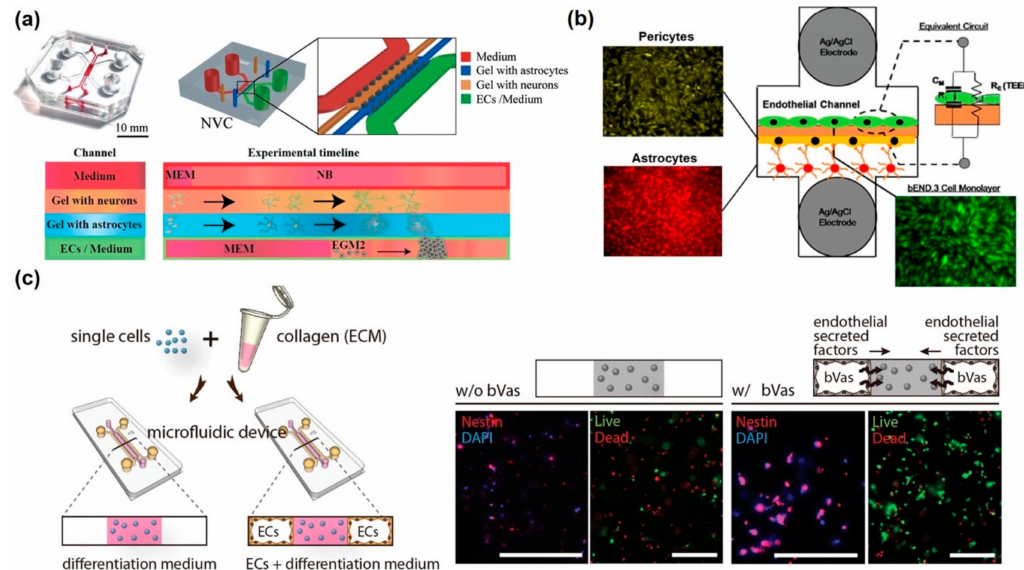
Figure 4. In vitro BBB-integrated neurovascular unit models. ( a ) Horizontal-aligned microfluidic neurovascular unit model with neuron, astrocyte, and endothelium. Reproduced with permission from [81]. Copyright 2017, The Royal Society of Chemistry (RSC). ( b ) Vertical-aligned neurovascular unit consisting neuron, astrocyte, pericyte, and endothelium with Ag / AgCl TEER electrodes. Reproduced with permission from [84]. Copyright 2016, ACS publication. ( c ) Horizontal-aligned neurovascular unit model with neural stem cells (NSCs) and endothelium for induction of crosstalk between NSC and endothelium. Reproduced with permission from [87]. Copyright 2014,